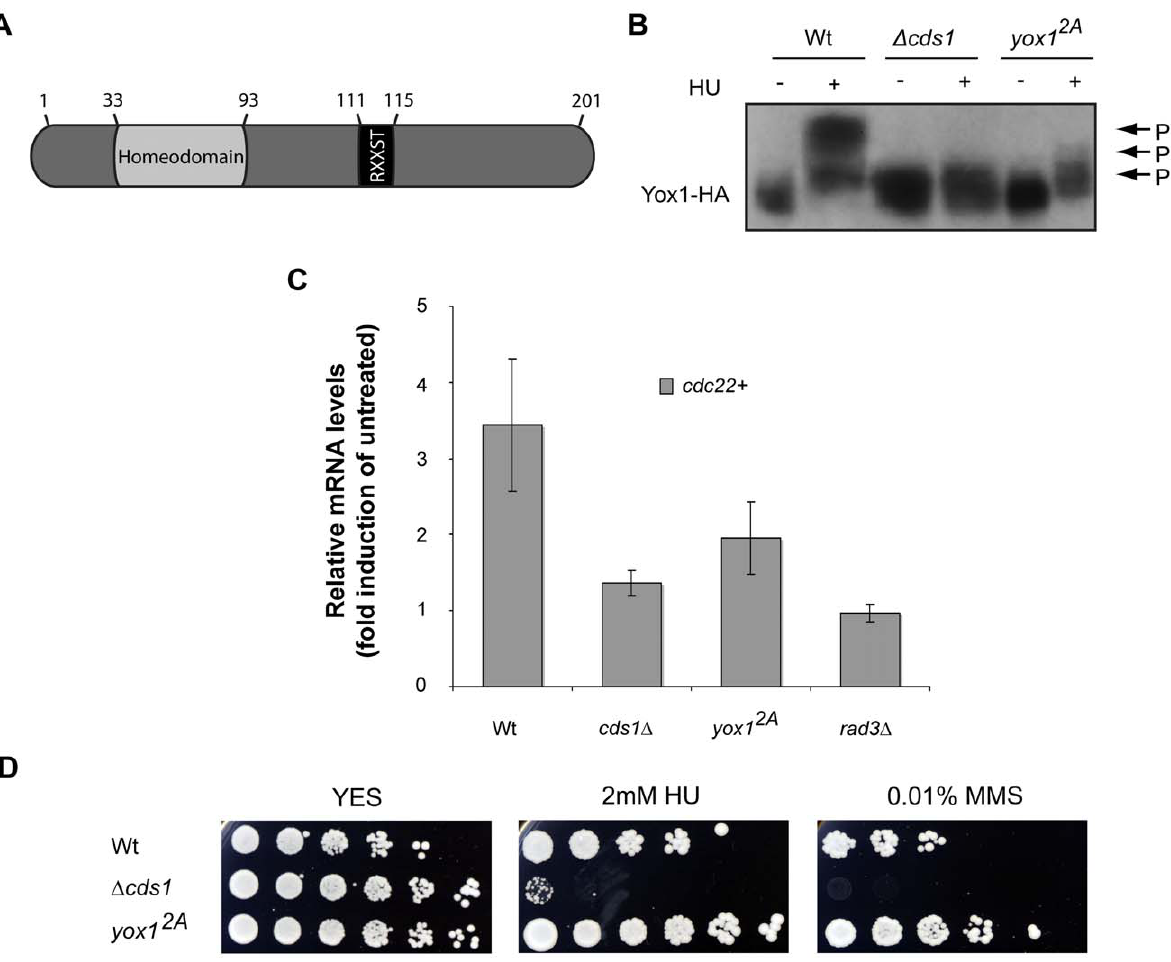
Figure 6. HU challenge induces phosphorylation of Yox1 at its RXXST consensus. (A) Cartoon diagram displaying the molecular arrangement of the homeodomain and the putative RXXS/T motif in Yox1p. Not to scale. (B) SDS-PAGE electrophoresis of Ha tagged Yox1 in untreated and HU-treated wt, D cds1 , and yox1 2A cells as described before. (C) RT-PCR analysis of cdc22 + transcript levels corresponding to fold induction over untreated wt for the same cells as in B and in rad3 D cells before formaldehyde-induced cross-linking. Bars represent the average value, and error bars represent their SD, obtained by qPCR of triplicate biological samples. (D) Five-fold serially dilution volumes of wt, yox1 2A and cds1 D , cells were spotted onto YES or YES plus indicated concentrations of HU or